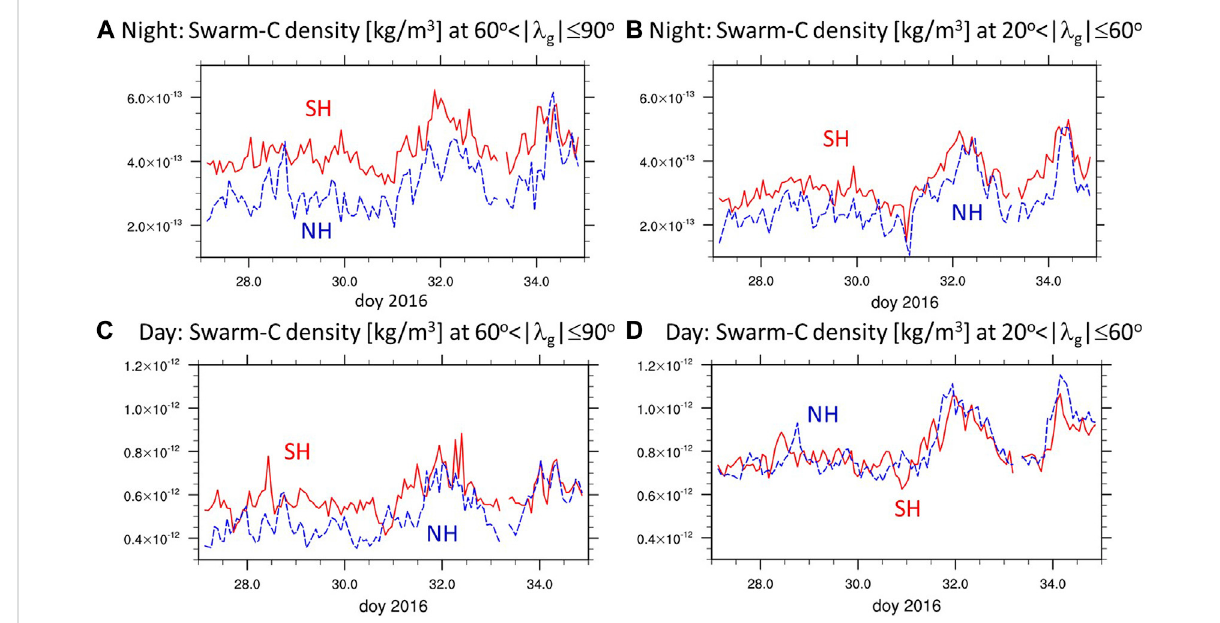
FIGURE 4 Averageneutraldensity [ kg / m 3 ]atSwarm-Corbitindifferentgeographic latitude λ g bins fortheSH(redlines) andNH(blue lines): (A) .Fornight- time orbit at 60 o < | λ g | < 90 o , (B) . For night-time orbit at 20 o < | λ g | < 60 o , (C) . For day-time orbit at 60 o < | λ g | < 90 o , (D) . For day-time orbit at 20 o < | λ g | < 60 o